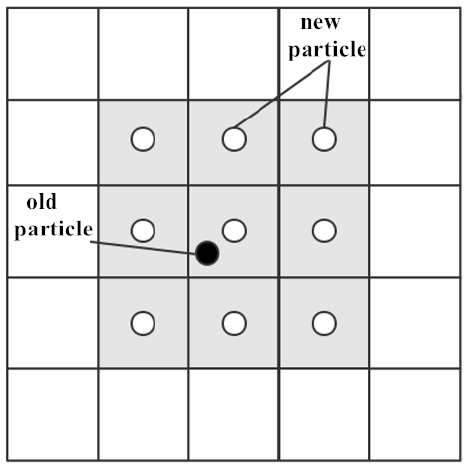
Figure 5. The schematic diagram of the redistribution of one vortex particle.